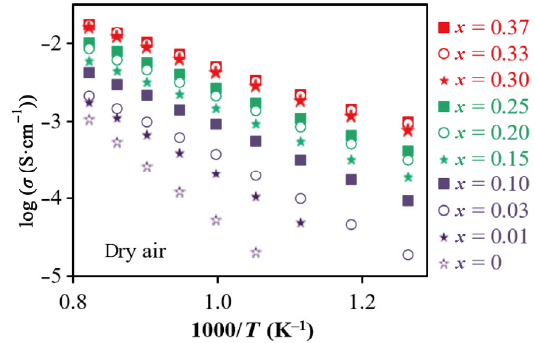
Fig. 2 Total σ for the BaSn 1 − x Sc x O 3 − δ ceramic materials in dry air atmosphere as a functional of reciprocal temperature.